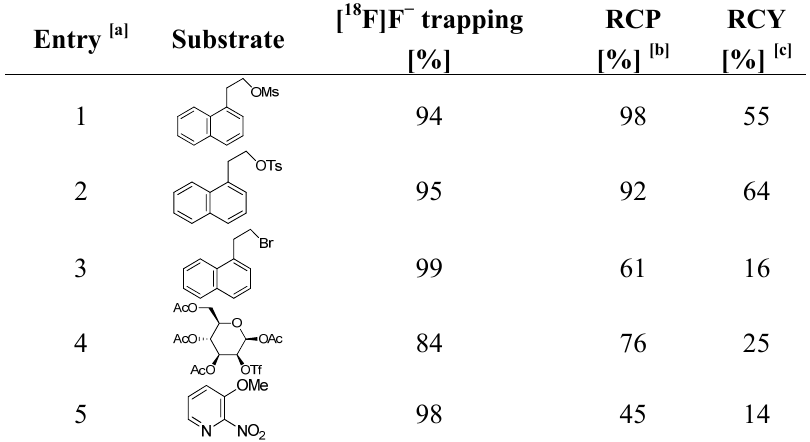
Table 1. Manual on-column radiofluorination using PS -P 2tBu : Preliminary